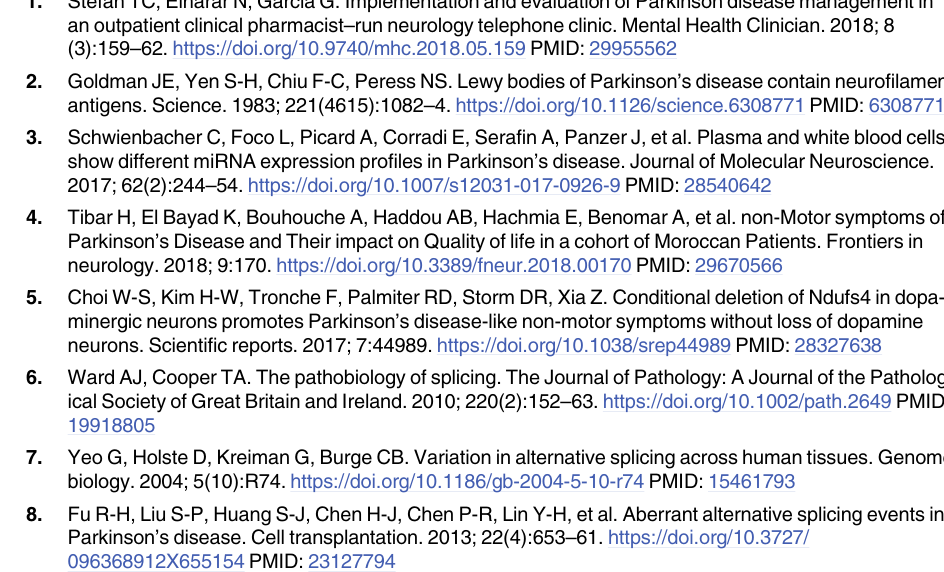
S2 Table. The accuracy and results of ROC curve for SRRM2 , miR-27a-3p, and miR-27b- 3p for detection ability of PD from healthy controls. AUC = area under curve. (PDF) S1 File. The values used to build